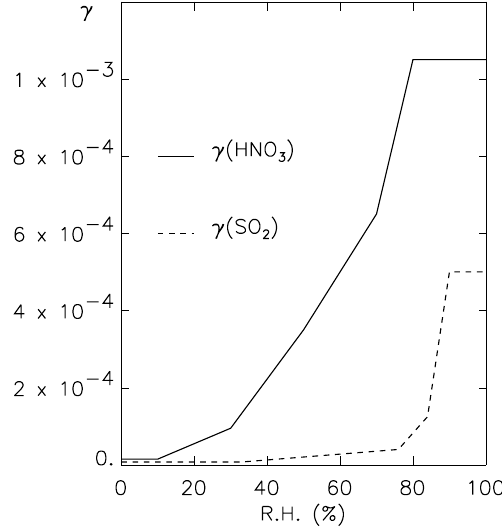
Fig. 1. Reactive uptake coefficients for HNO 3 (g) and SO 2 (g) on mineral dust used in this study as a function of relative humidity